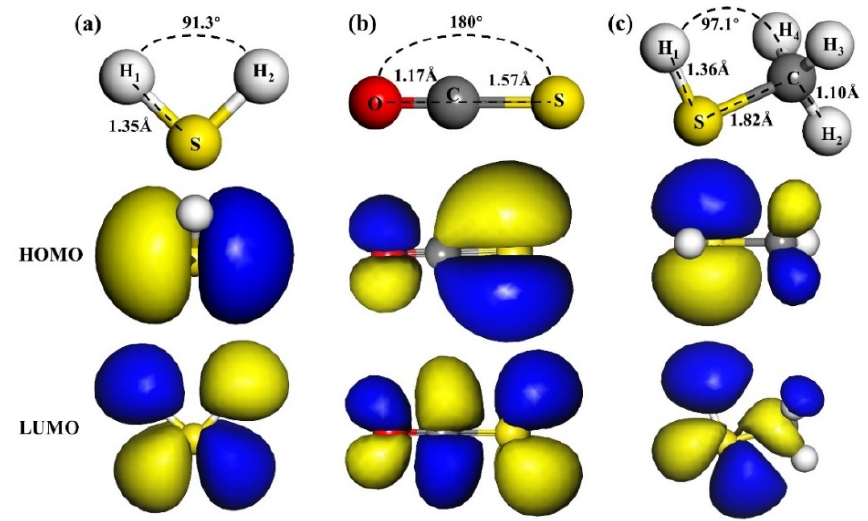
Figure 3. The geometrically optimized ( a ) H 2 S, ( b ) COS, and ( c ) CH 3 SH molecules, and their HOMO (Highest Energy Occupied Orbital) and LUMO (Lowest Energy Empty Orbital).